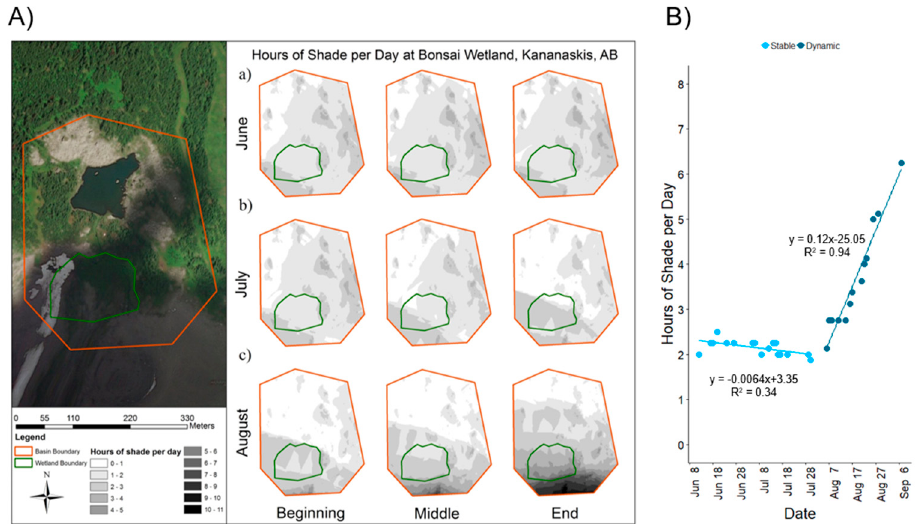
Figure 4. ( A ) Horizon shade model results for the beginning, middle and end of each month for ( a ) June, ( b ) July and ( c ) August during the 2018 study period. Inset image illustrates the position and orientation of the study site (enclosed by the wetland boundary) relative to the surrounding topog- raphy, with the wetland boundary highlighted with a green line. ( B ) Stable Shade (7 June to 30 July), illustrated by light blue circles, has a consistent average daily shade value of 2 (y = − 0.01x + 3.35, R 2 = 0.34) while Dynamic Shade (31 July to 10 September), dark blue circles, increases rapidly over time (y = 0.12x − 25.05, R 2 = 0.94).